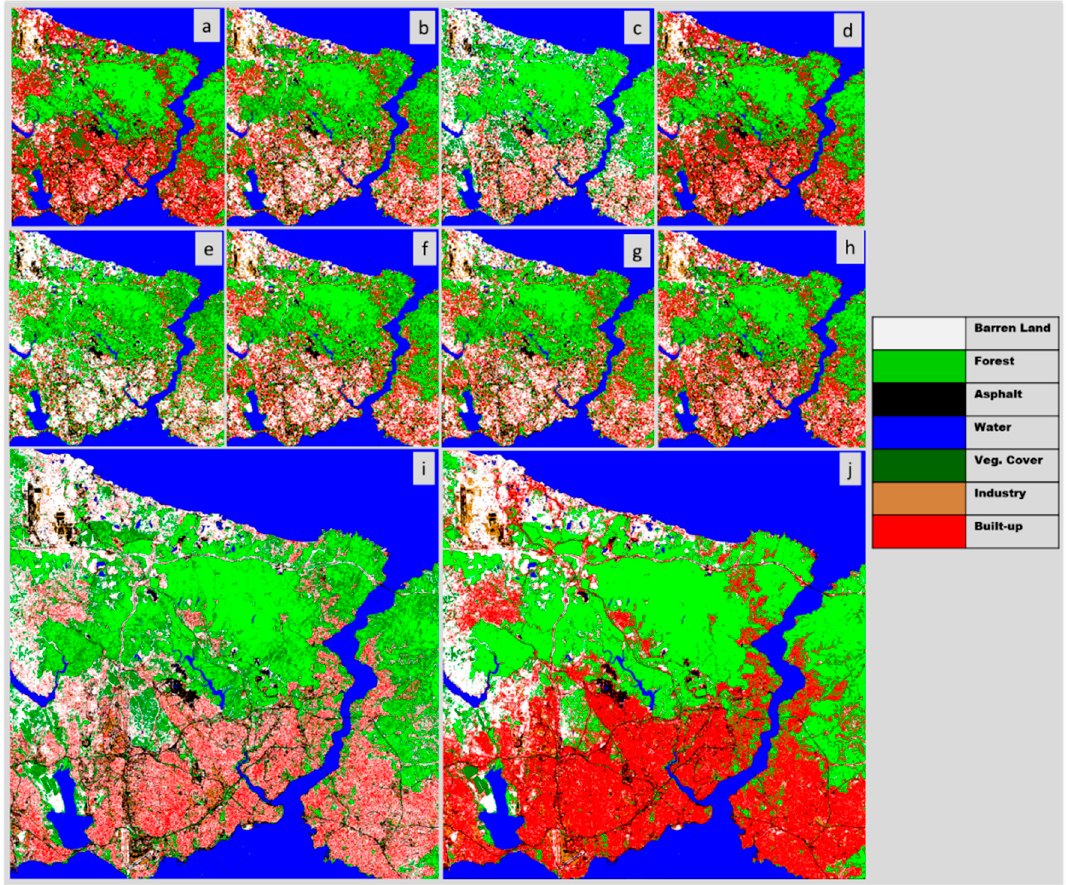
Figure 7. Classification results of: ( a ) NDBI; ( b ) BUI; ( c ) BAEI; ( d ) NBI; ( e ) VIBI; ( f ) IBI; ( g ) UI; ( h ) BSI; ( i ) NDTI-based multi index sets; and ( j ) original spectral bands. Table 4. Classification accuracies of the different approaches for the Istanbul region.